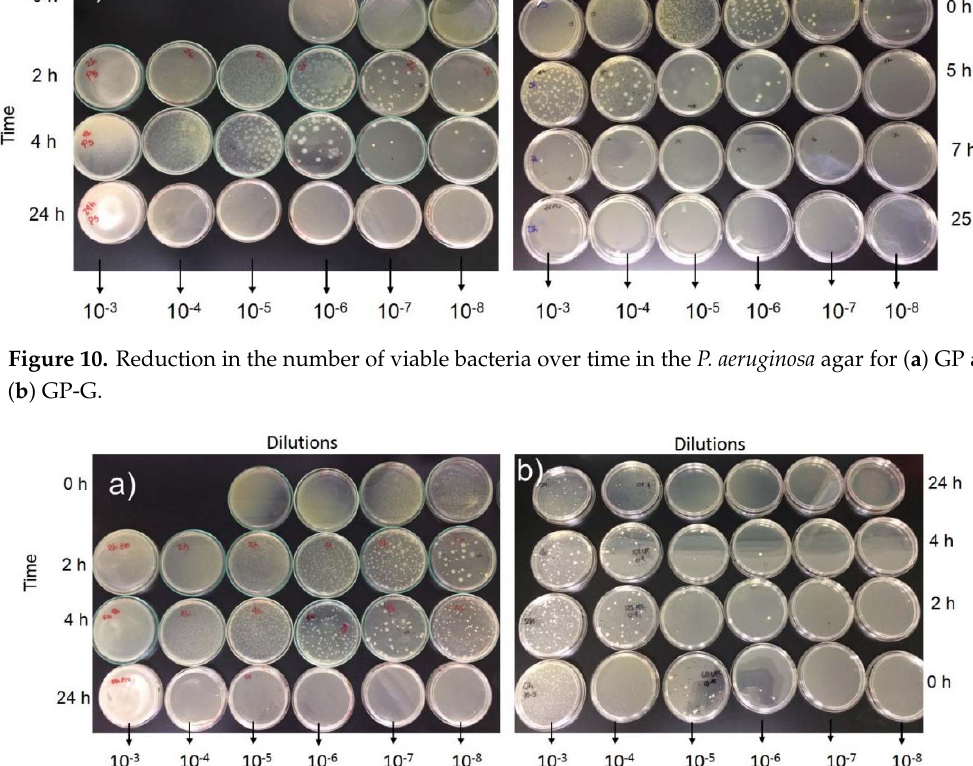
Figure 9. Reduction in the number of viable bacteria over time in the S. aureus agar for ( a ) GP and ( b ) GP-G. Table 6. Bacterial growth inhibition capacity of GP (24 h) and GP ‐ G (25 h) in bacteria ‐ rich agar solutions.